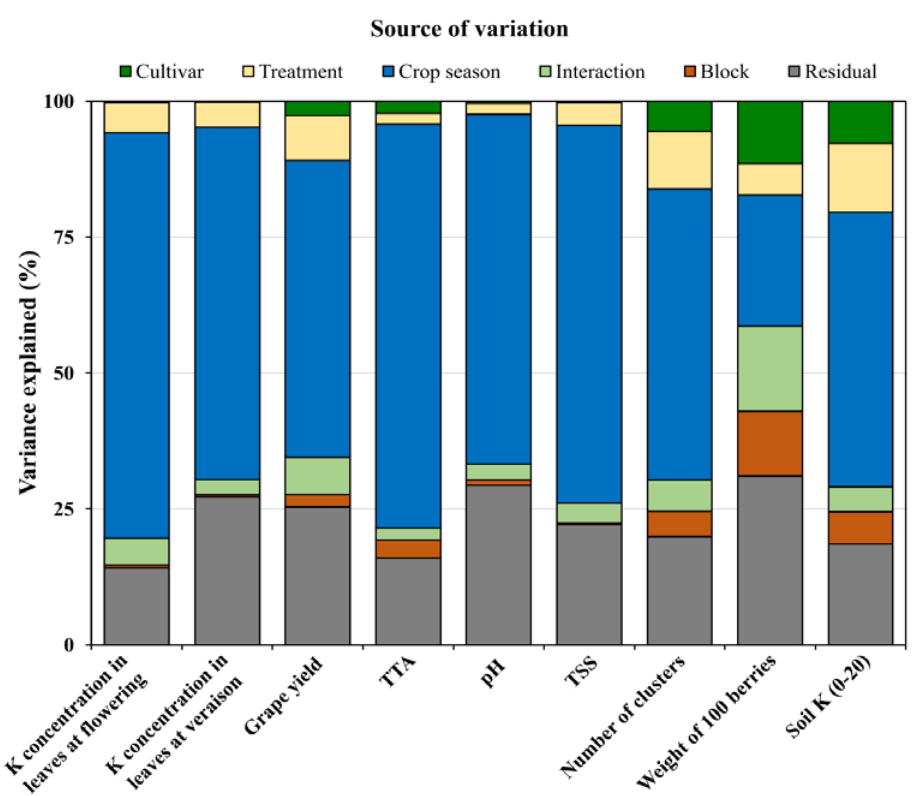
Figure 2. Visual representation of variance components. The colors represent the source of variation (cultivar, K doses, crop season, interaction, block and residual). Response variables (plant tissue, grape yield, and must composition) are shown on the X -axis. The proportion explained by each source of variation for each response variable is observed on the Y -axis (percentage). Interaction = cultivar x treatment x crop season. TTA = Total Titratable Acidity; TSS = Total Soluble Solids.